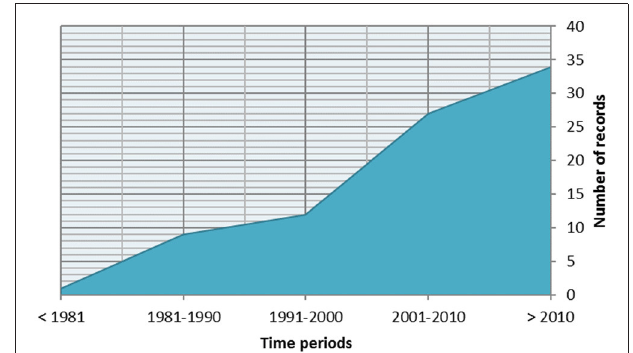
FIGURE 3 | Distribution of retrieved records by country. “Others” includes papers from the following nations: Greece, Netherlands, Sweden, Belgium, Brazil, Denmark, Finland, Japan, South